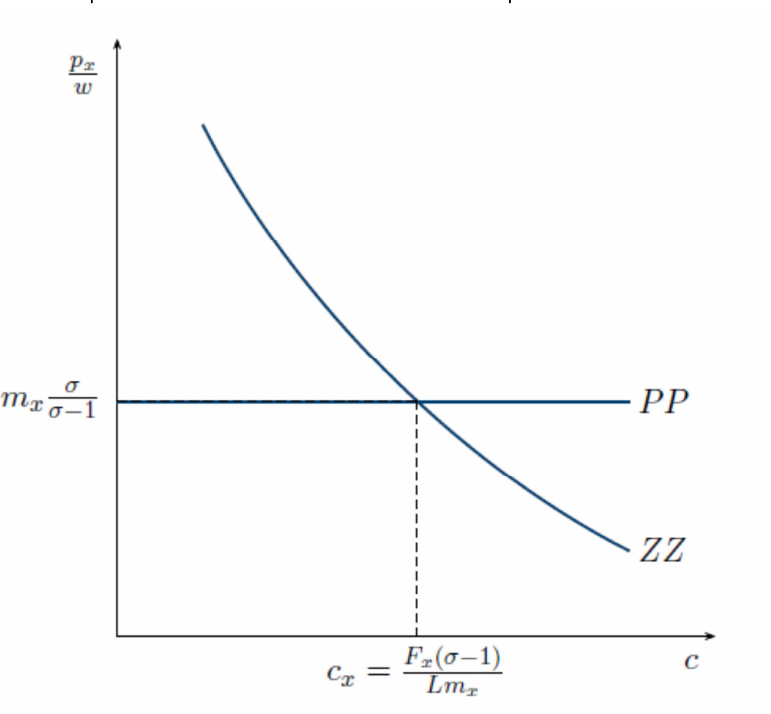
Figure 1. Equilibrium in the market for differentiated